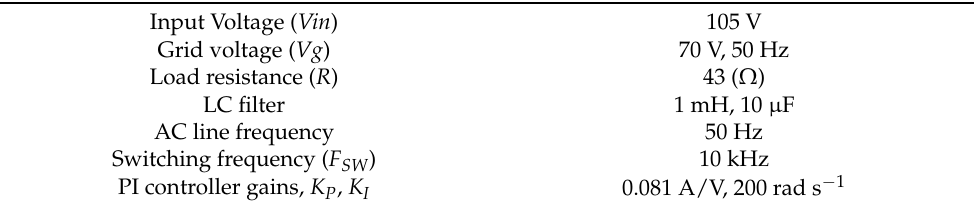
Table 5. Experimental system parameters.